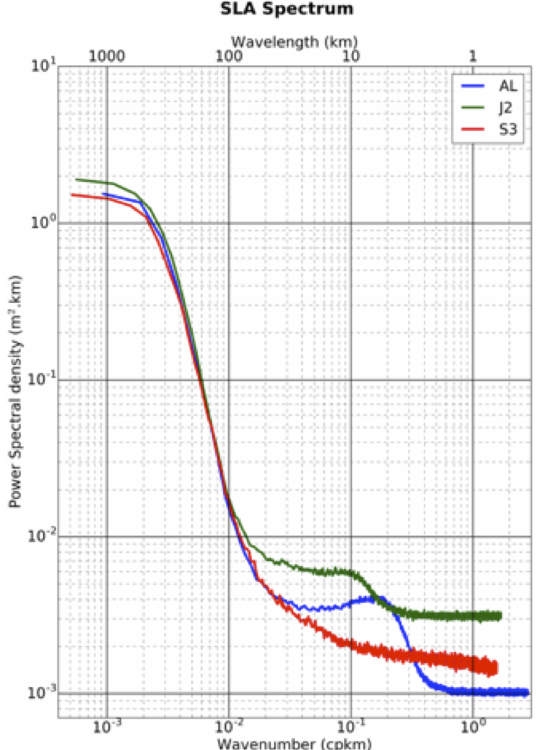
Figure 1. Globally-averaged wavenumber spectra of SSH anomalies (in m 2 /cpkm) from the highest resolution along-track data for three different missions: Jason-2 20 Hz (J2 in green); SARAL/AltiKa 40 Hz (AL in blue); and Sentinel-3 20 Hz SAR (S3 in red). The spectral “bump” in Jason-2 and SARAL/AltiKa data is due to surface roughness inhomogeneities within the footprint, mainly from surface waves.